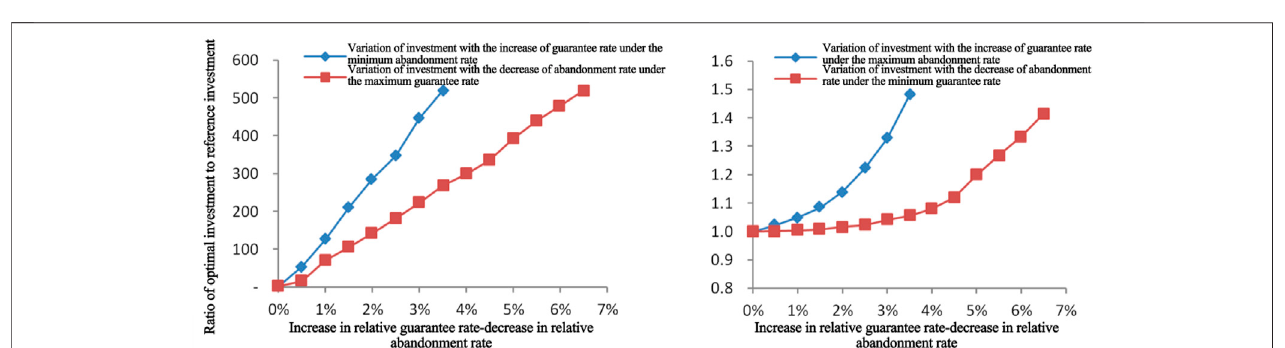
FIGURE7 | Comparison ofthe in fl uence ofabandonmentrateand guarantee rate oninvestmentin thecase ofhigher investment (left)and lowerinvestment(right).